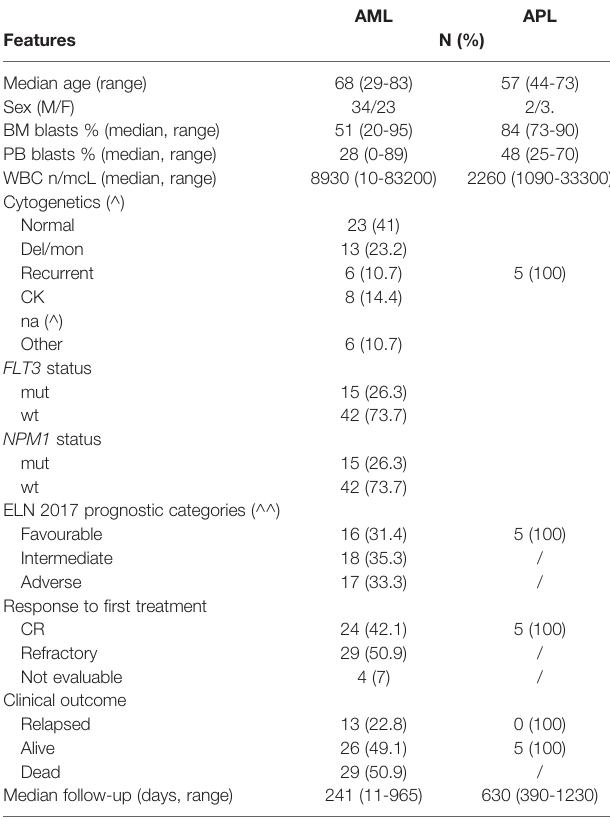
TABLE 1 | Clinic-biological features of